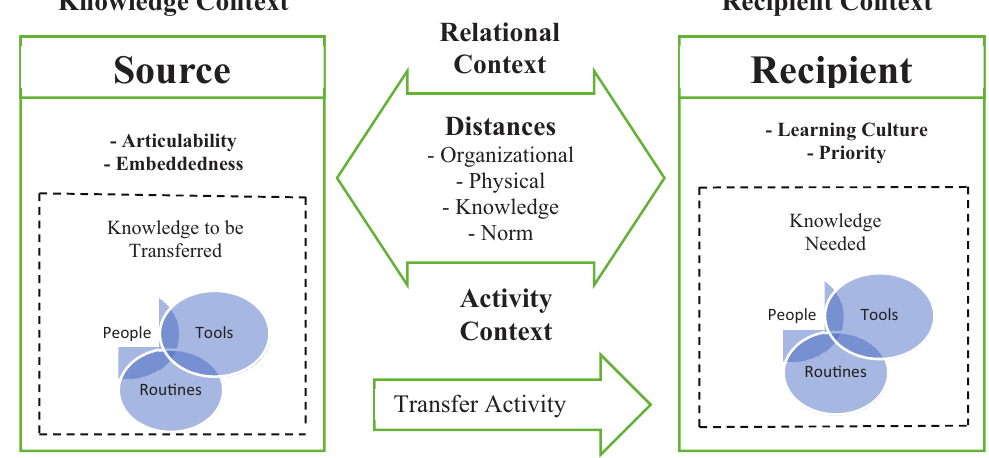
Figure 8. The model of transfer success with nine key factors affecting knowledge by Cummings and Teng